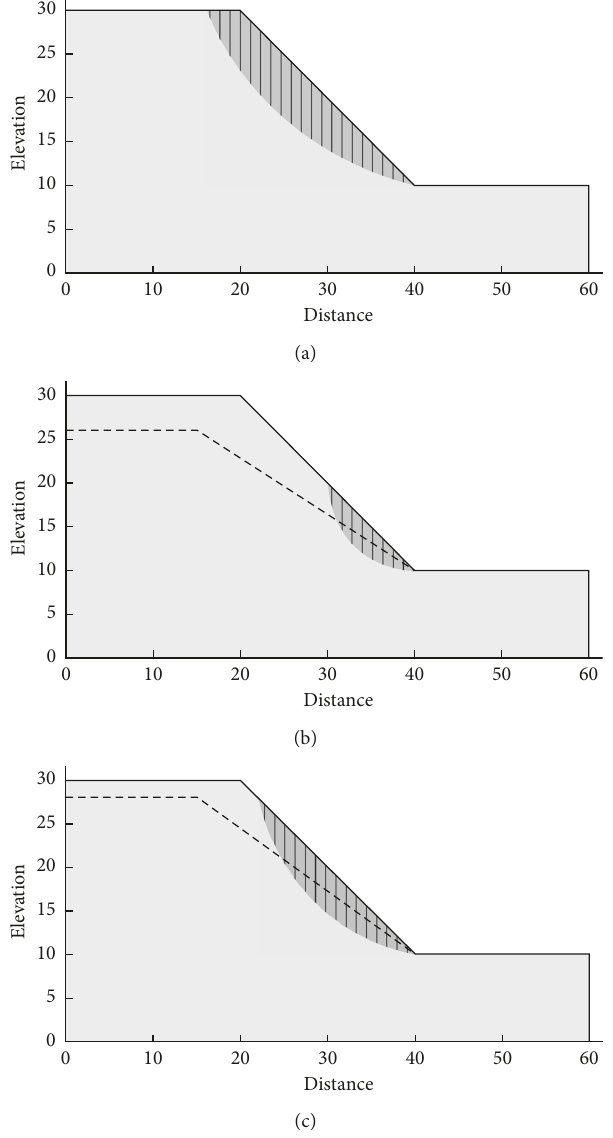
Figure 8: Slope stability analysis of Experiment 1 at collapse state (varied soil density). (a) Initial condition. (b) At appearance of minor slip/scarp. (c) At